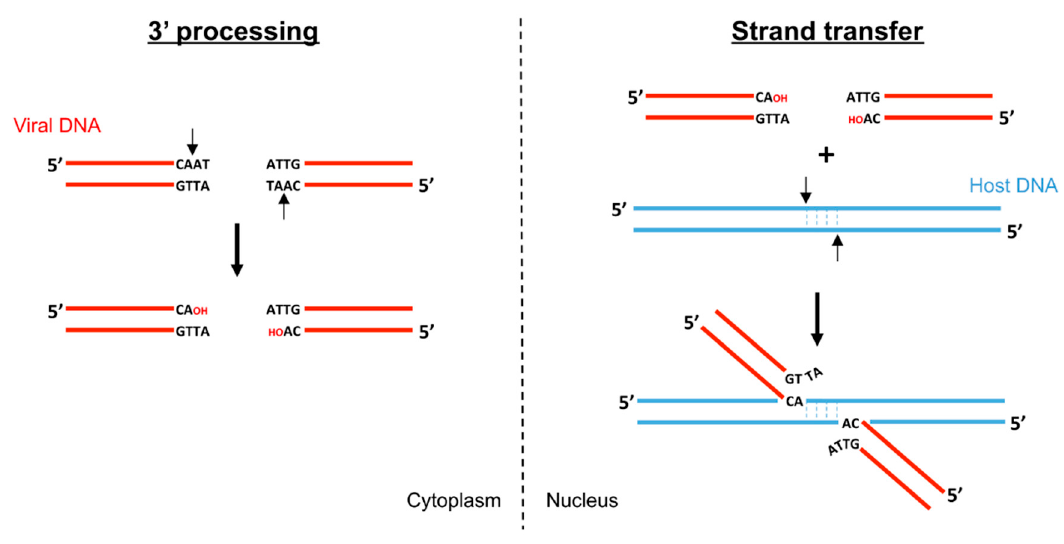
Figure 1. DNA cutting and joining steps catalyzed by retroviral integrases. During 3’ processing (left) the integrase removes two (or three) nucleotides from the 3’ ends to expose a conserved terminal CA dinucleotide. The 3’ hydroxyl groups (red OH) will be used in the second step (right) to attack the phosphodiester bonds on each target DNA strand.